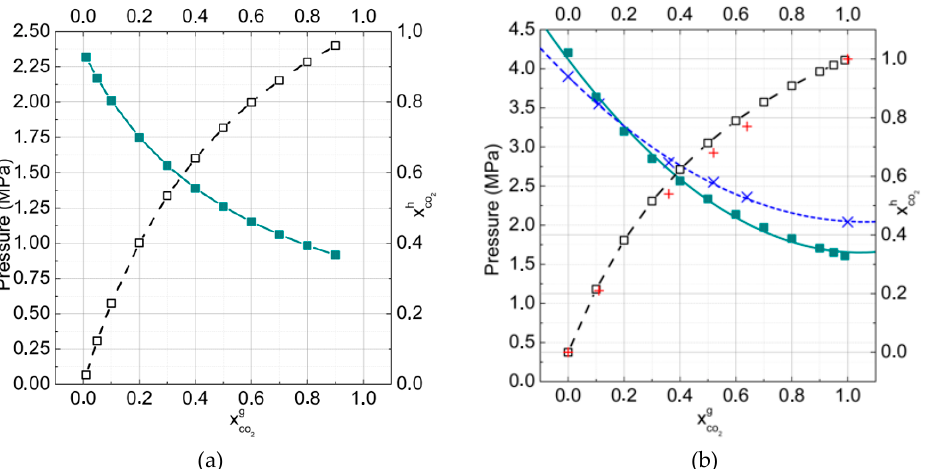
Figure 5. P - x diagram of the binary hydrates of methane and carbon dioxide at ( a ) T = 273 K and ( b ) T = 277 K. Skew crosses = the experimental data [47] of mole fraction carbon dioxide in the hydrate phase; crosses = experimental data [47].